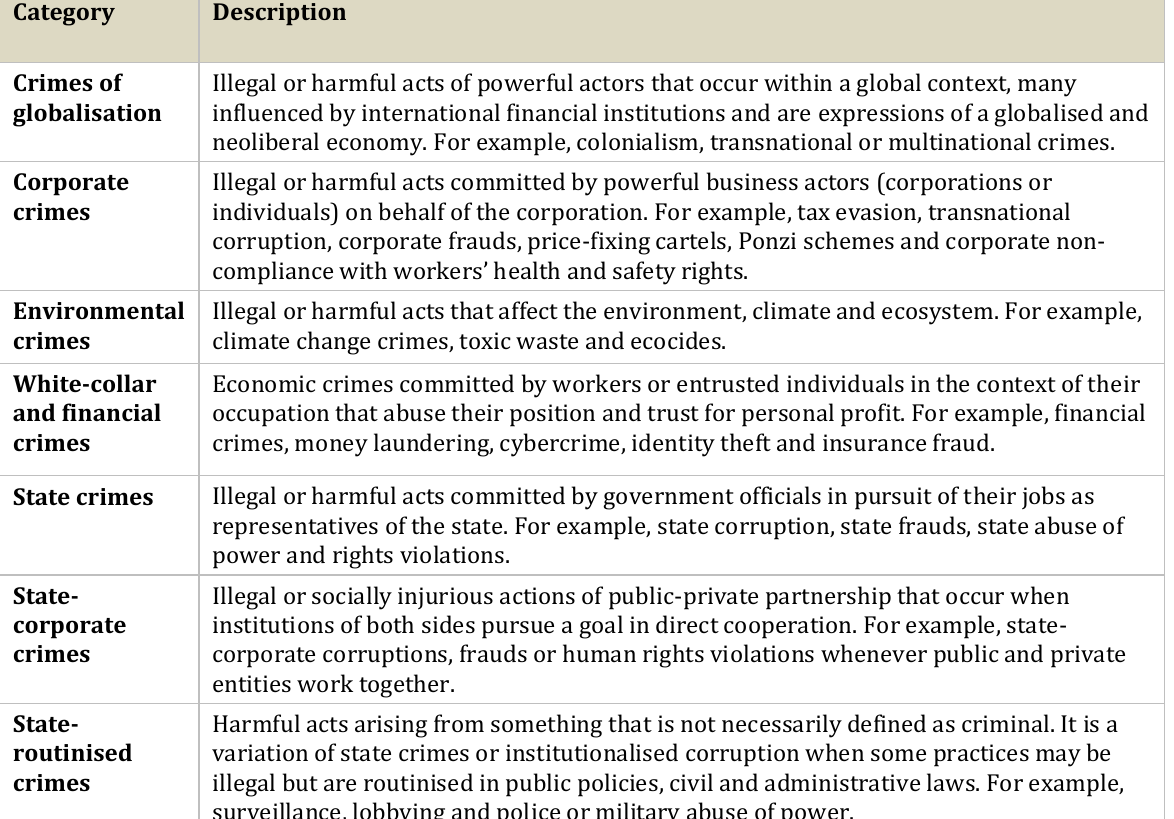
Table 1: Crimes of the powerful